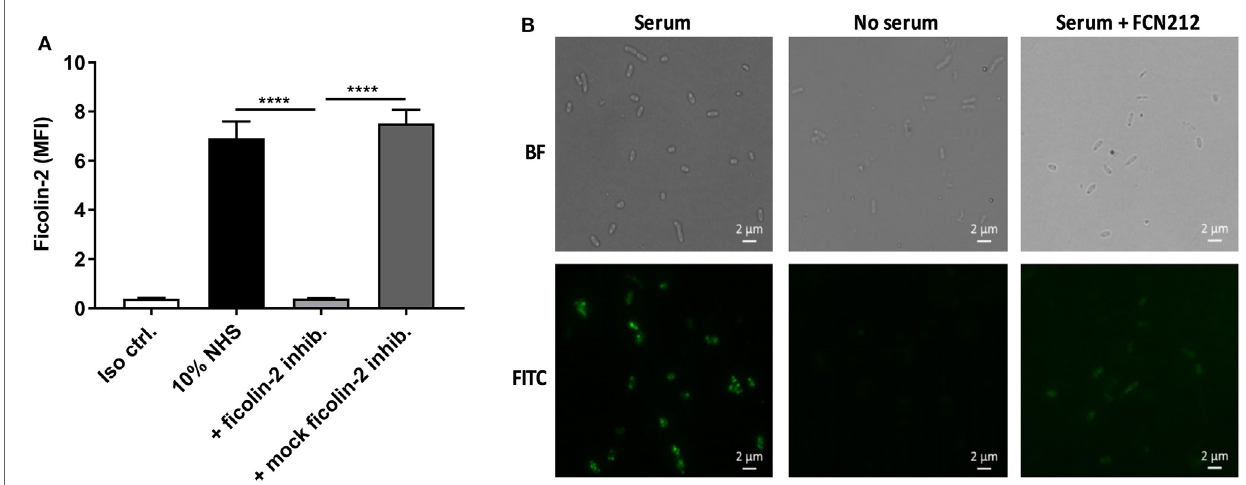
FigUre 5 | Inhibitory effects of ficolin-2 inhibitor on ficolin-2 binding. 10% normal human serum (NHS) was combined with ficolin-2 inhibitor FCN212 (5 µg/ml) and incubated with isolate C322-17. Detection was performed with specific biotinylated monoclonal antibodies against ficolin-2, followed by FITC-conjugated Streptavidin. (a) Ficolin-2 deposition was measured by flow cytometry and expressed as mean fluorescence intensity (MFI). (B) Residual EAEC cells from flow cytometry was placed on slides by cytospin and examined by bright field (BF) and fluorescent microscopy (FITC). Results represent the means of three independent experiments ± SD, **** p ≤ 0.0001 (unpaired Student’s t